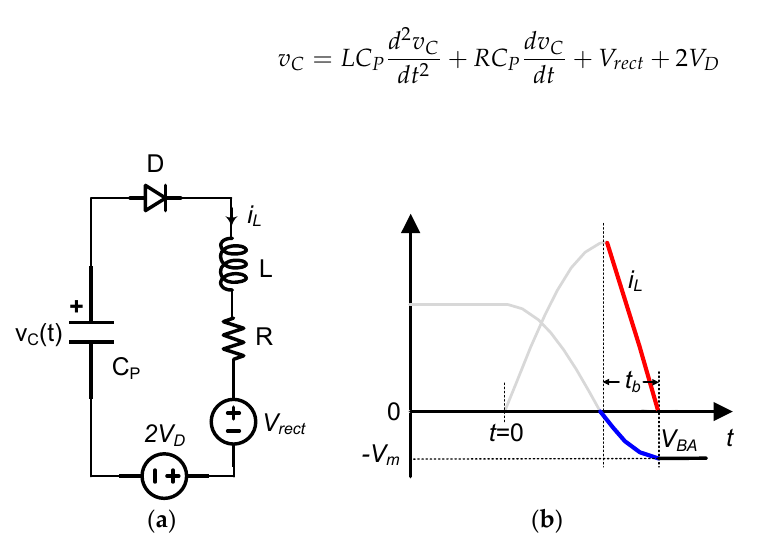
Figure 8. ( a ) Model of the second resonant loop, and ( b ) its